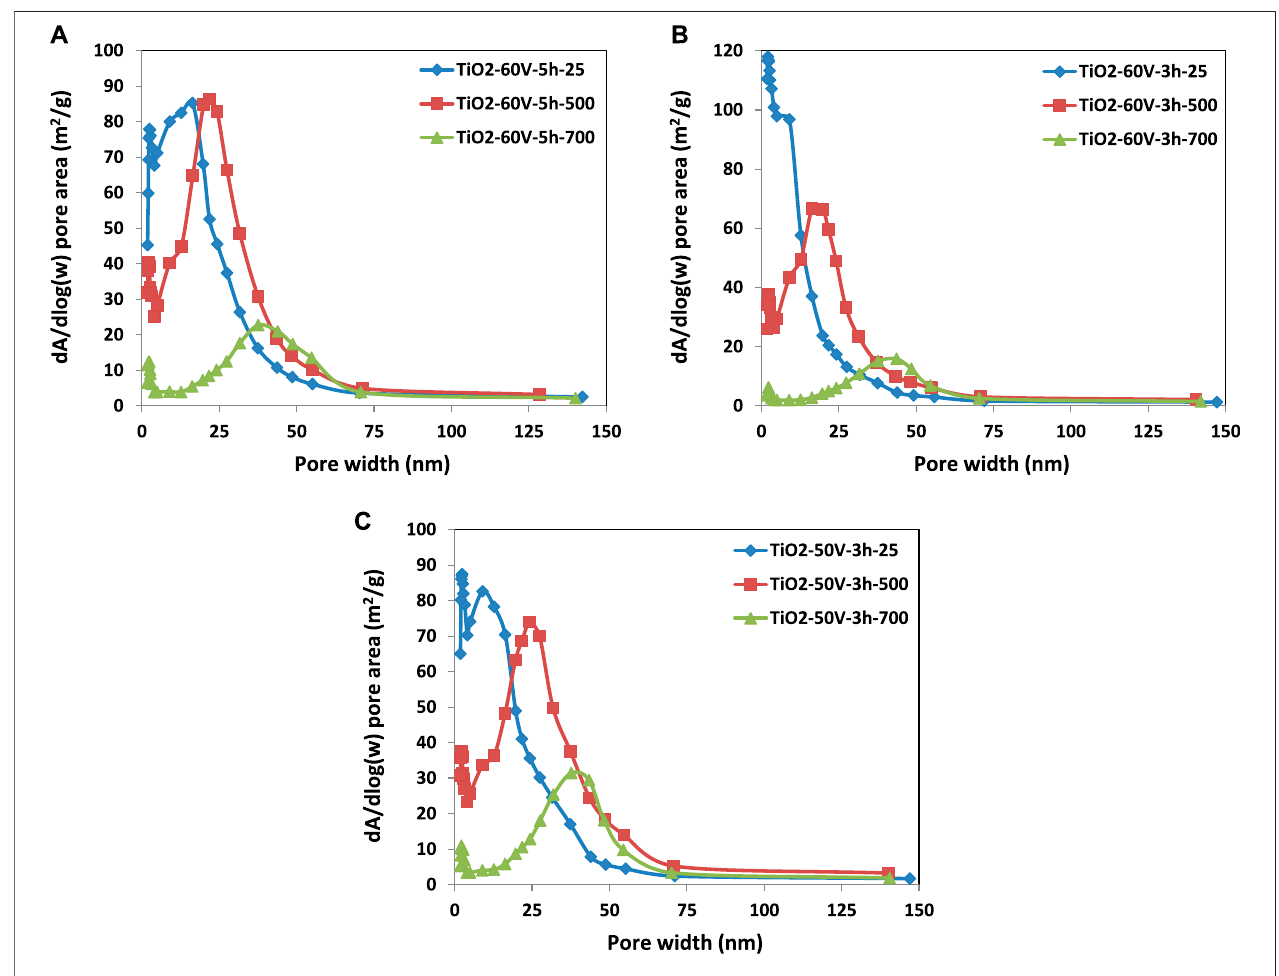
FIGURE 6 | Pore size distribution versus pore area of the TiO 2 samples: (A) TiO 2 -60V-5h, (B) TiO 2 -60V-3h, and (C) TiO 2 -50V-3h.